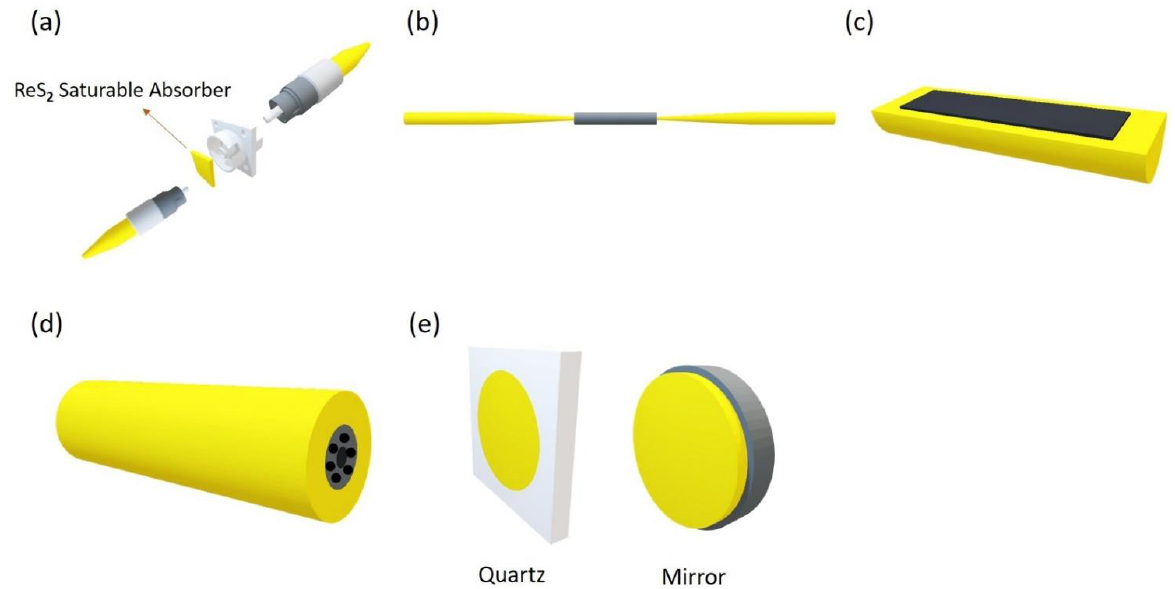
Figure 12. Integration platform for 2D materials to make SA devices. ( a ) Sandwiched between two fiber connecters using fiber adapter. ( b ) Tapered fiber. ( c ) D-shaped (side-polished) fiber. ( d ) Photonic crystal fiber. ( e ) Substrate (e.g., quartz glass plate or mirrors) for free-space coupling.